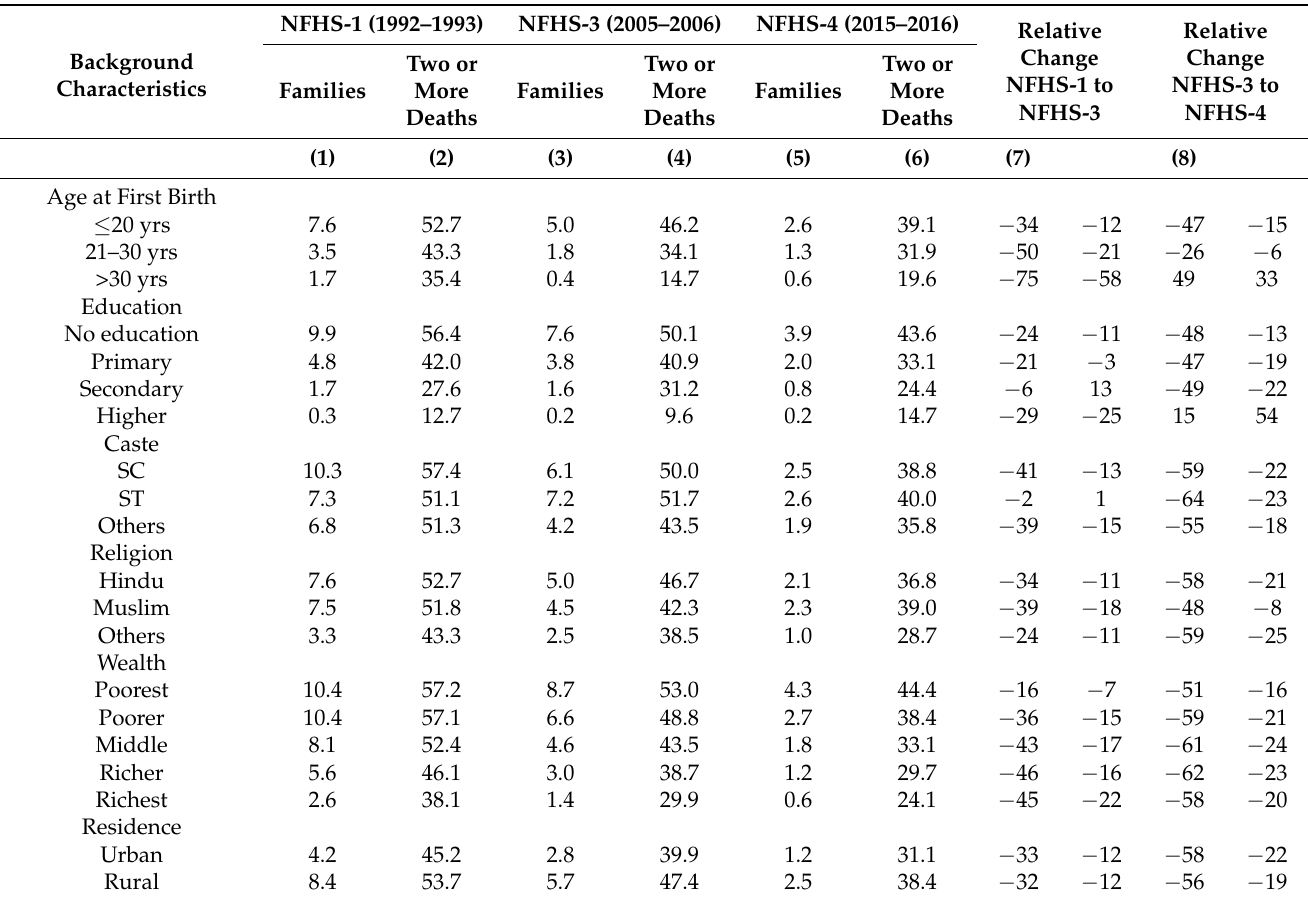
Table 3. Infant death clustering in families and extent of clustered deaths in families by selected background characteristics, India,